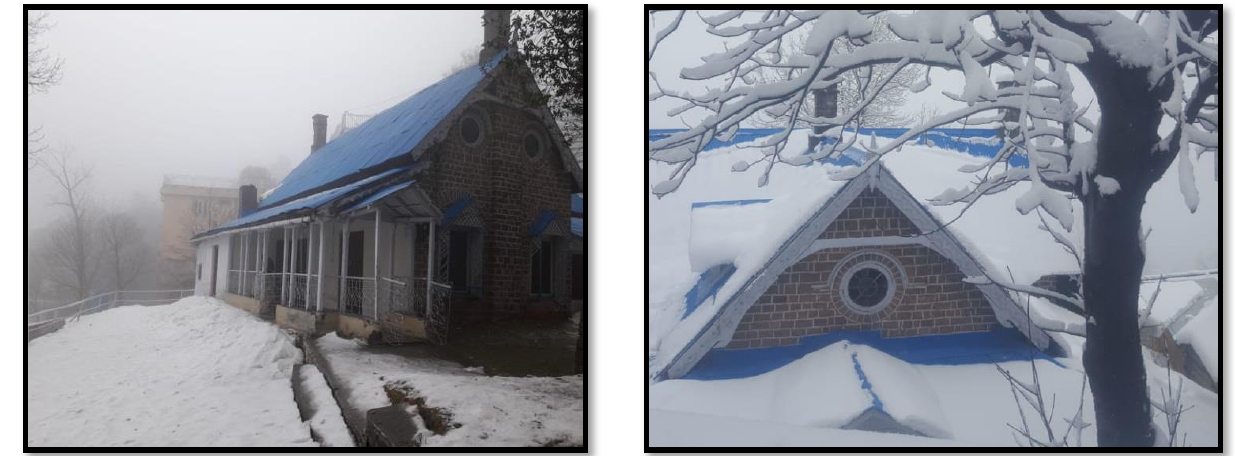
Figure 4. Exterior Views of the case study building with snow coverage.